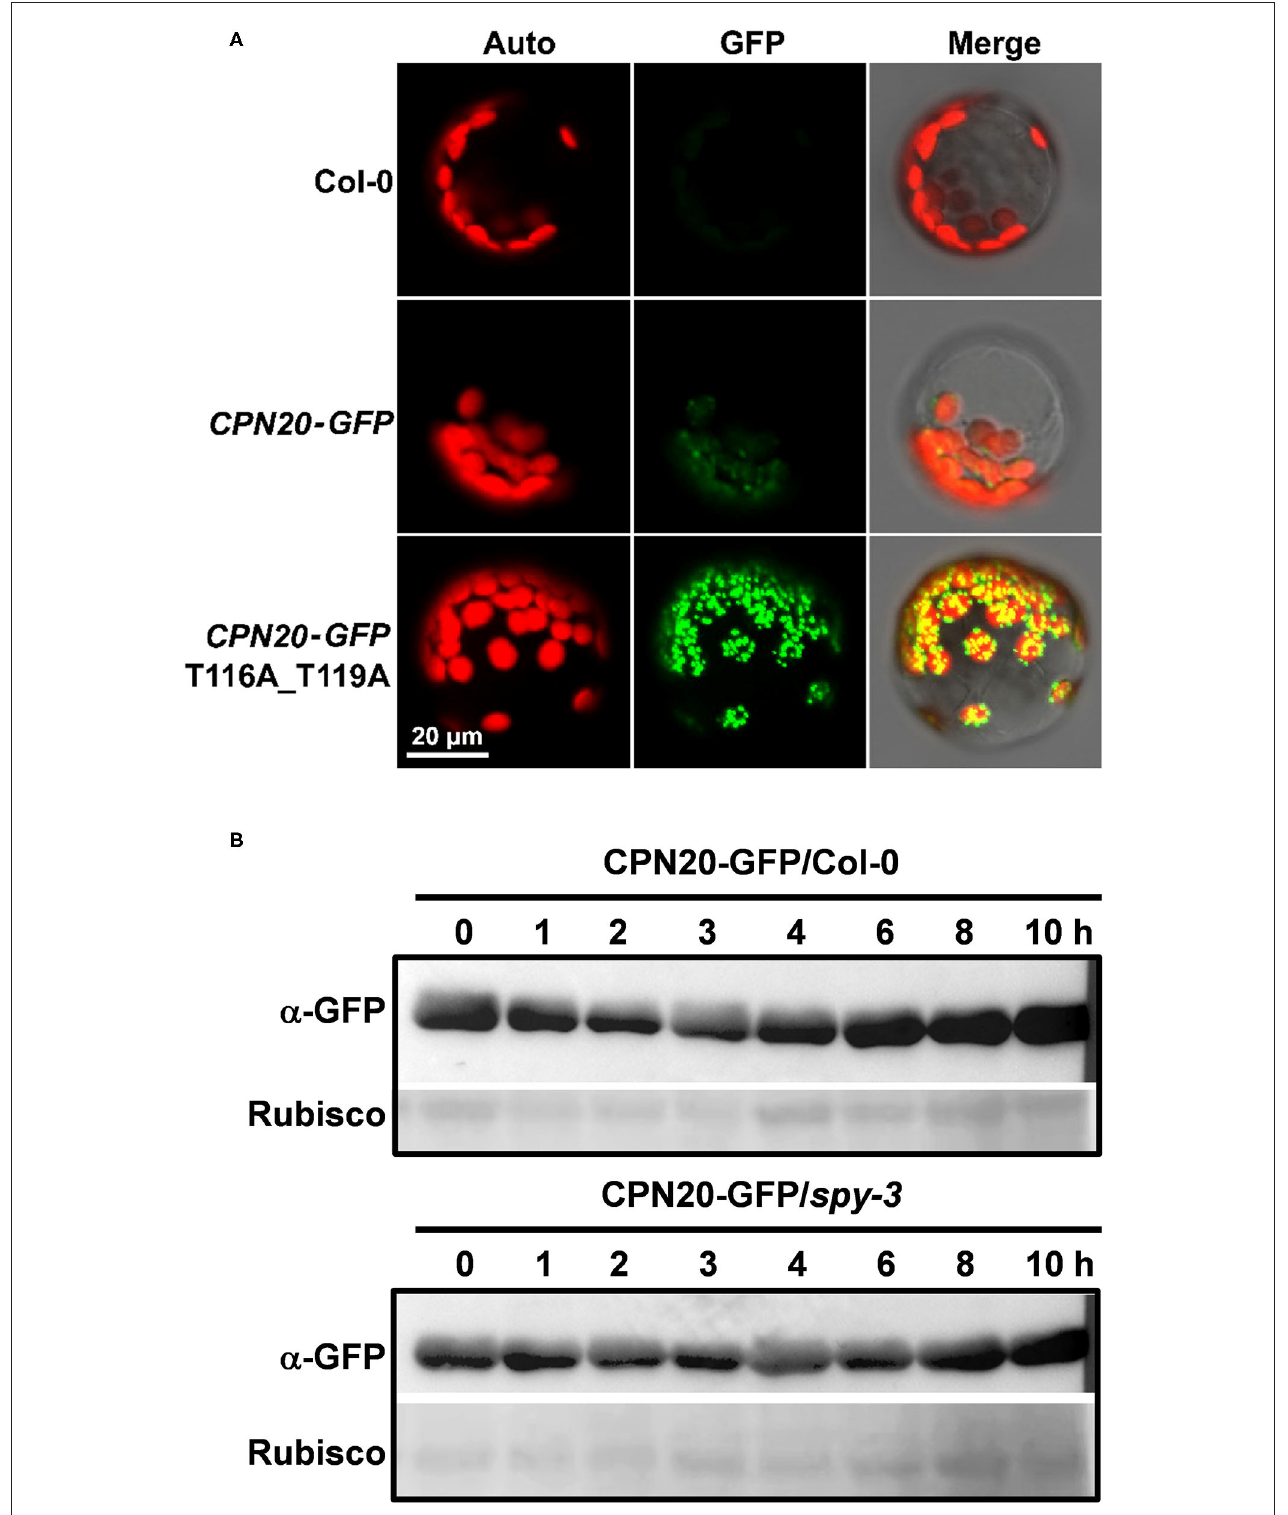
FIGURE 5 | Effect of CPN20 mutation at the O -fucosylation sites or SPY mutation on chloroplast localization or stability of CPN20. (A) CPN20 mutation at the O -fucosylation sites affects the localization of CPN20 in the chloroplast. Plasmids of GFP fused downstream of wild-type full-length ORF of CPN20 and mutated CPN20 with T116a and T119A were transformed into mesophyll protoplasts prepared from leaves of 30-day-old Col-0 plants. Auto, GFP, and Merge indicate